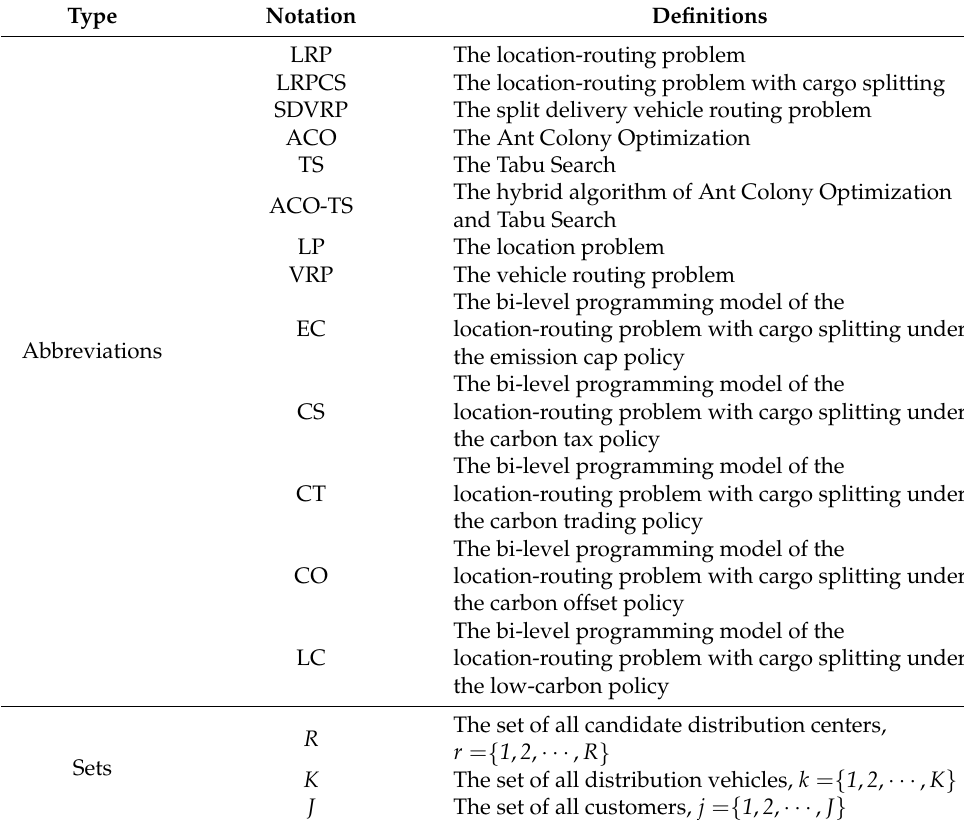
Table 2. Abbreviations, sets, parameters, and decision